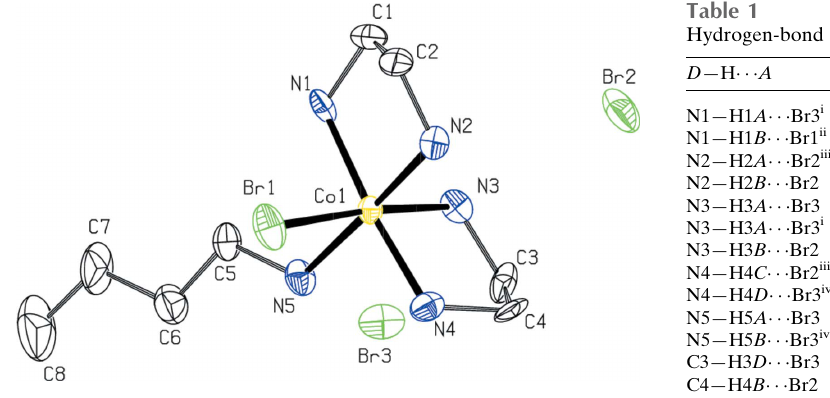
Figure 1 Molecular structure of the title compound, with the atom labelling. Displacement ellipsoids are drawn at the 50% probability